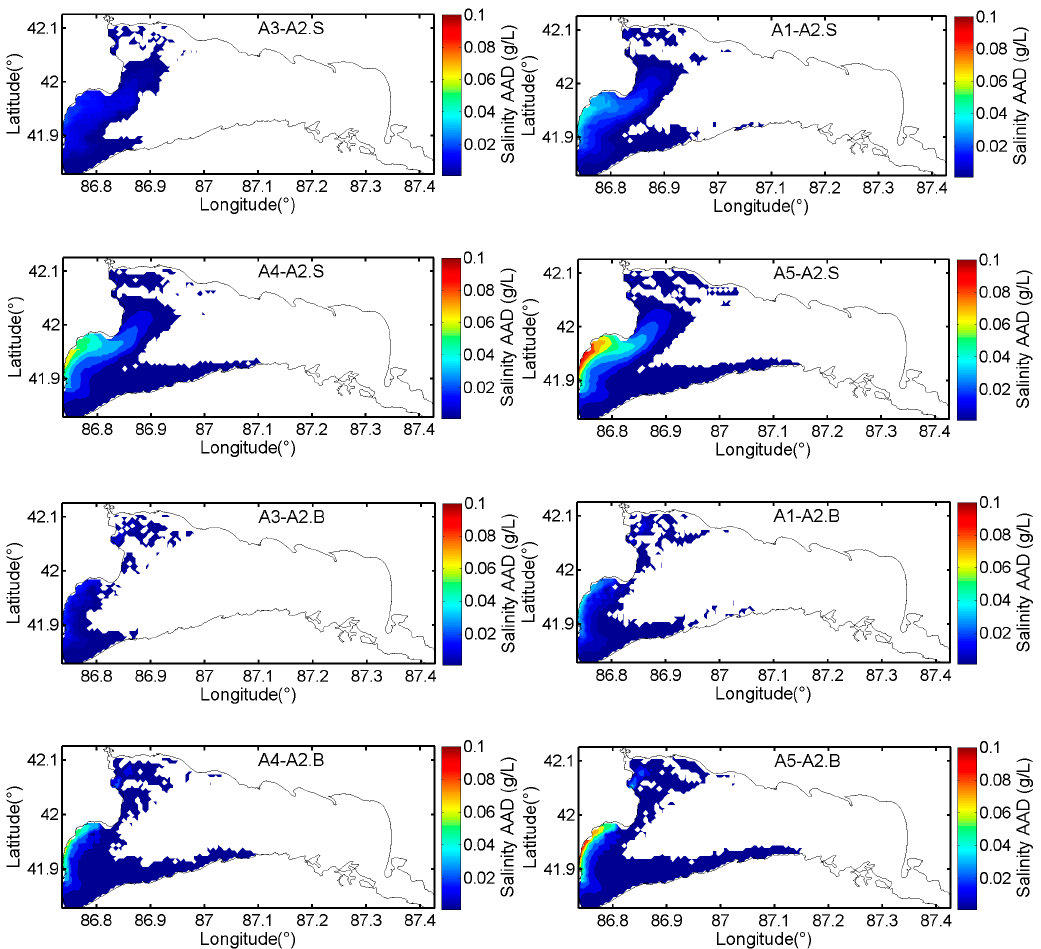
Figure 11. The Salinity average absolute differences (AAD) distributions between experiments at surface ( A3-A2.S ) A3-A2, ( A1-A2.S ) A1-A2, ( A4-A2.S ) A4-A2, and ( A5-A2.S ) A5-A2, and at the bottom ( A3-A2.B ) A3-A2, ( A1-A2.B ) A1-A2, ( A4-A2.B ) A4-A2, and ( A5-A2.B )